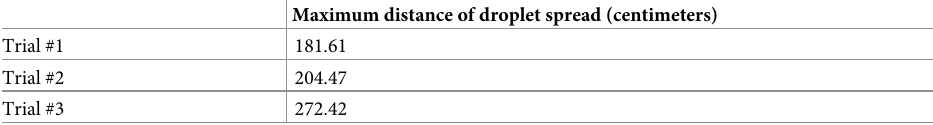
The fourth experiment was designed to determine the height of droplet spread on the bar- rier, as well as whether droplets spread on the inside of the top cover and anywhere outside the barrier. As shown in Table 4, the maximum height of droplet spread on the barrier from the fourth experiment was 90.50 centimeters, with a range of 88.70 centimeters to 90.50 centime- ters. Droplets were also found on the inside of the top cover of the barrier in each trial. Drop- lets were most dense on the board at the height of the mouth of M1 and were found farther Table 1. (Experiment 1): Maximum distance of droplet spread traveling straightforward on the table. Maximum distance of droplet spread